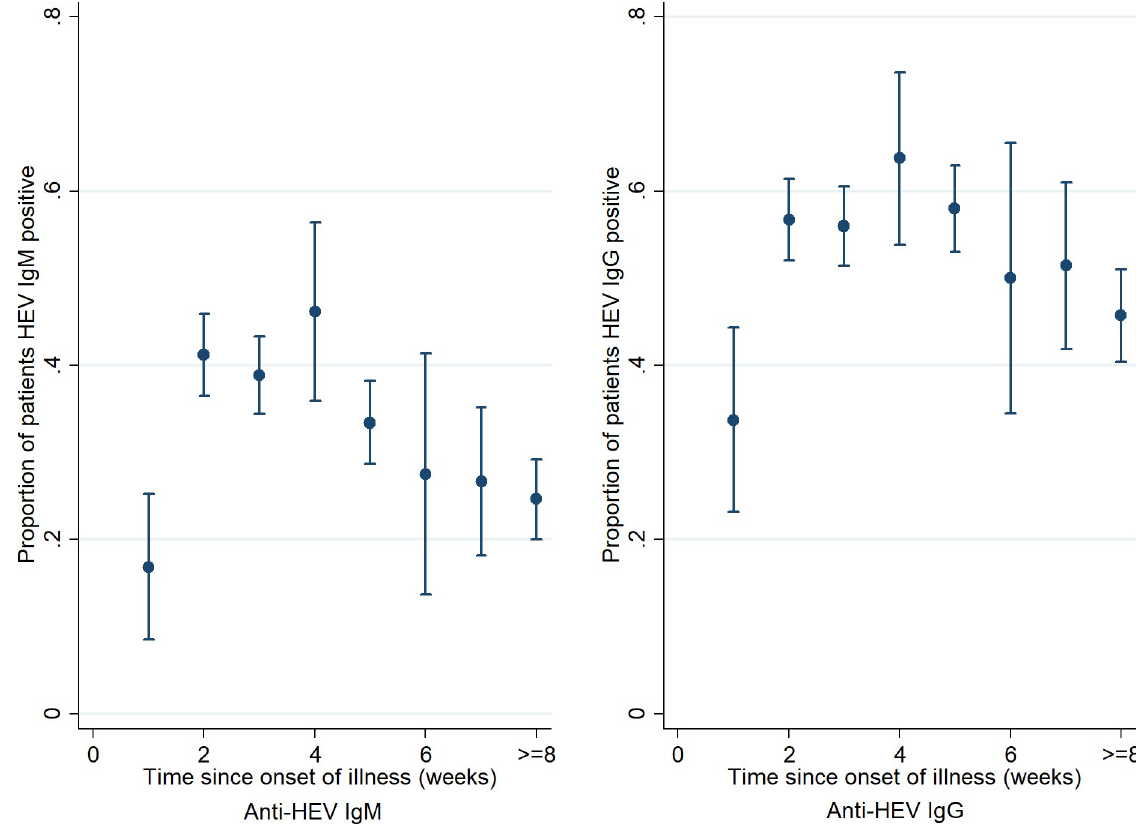
Fig 2. Proportion of patients positive for anti-HEV IgM and anti-HEV IgG by duration of illness at the time of admission to hospital in six tertiary hospitals in Bangladesh, December 2014- September